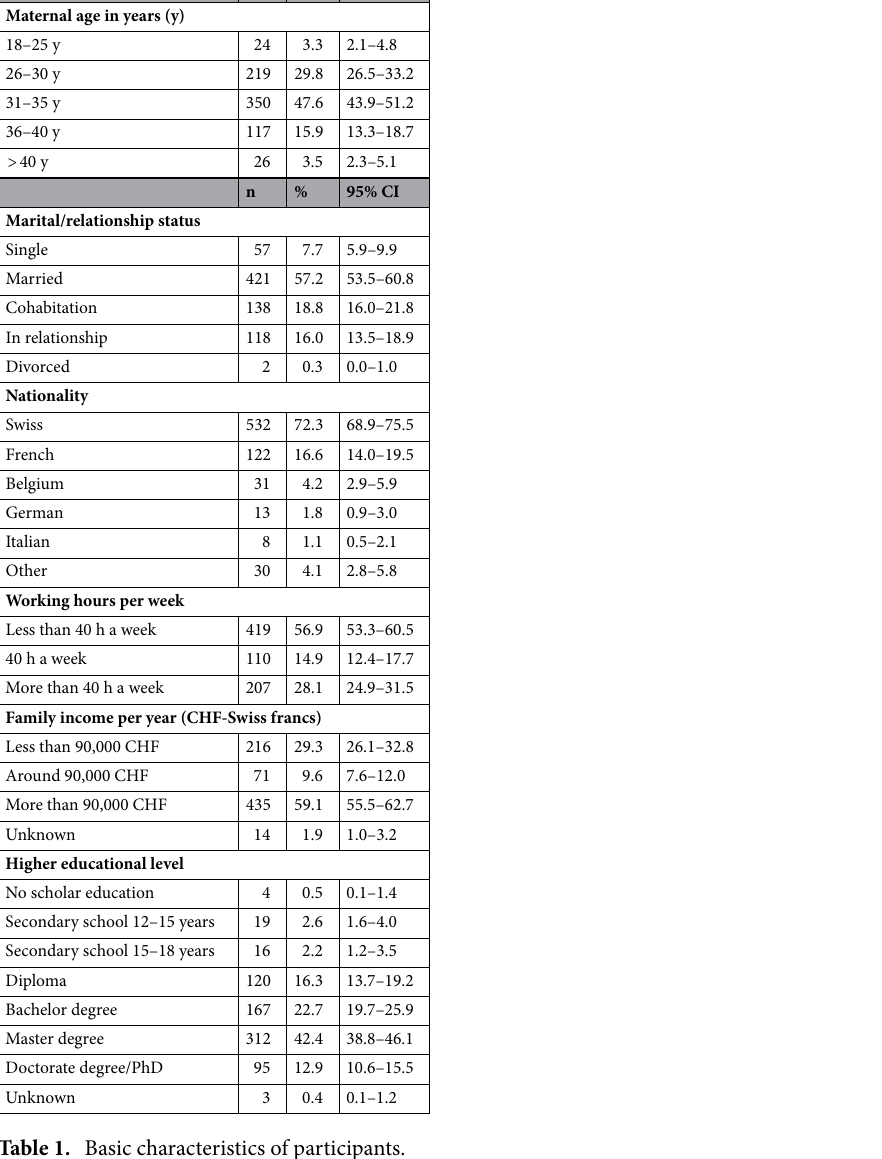
Table 1. Basic characteristics of